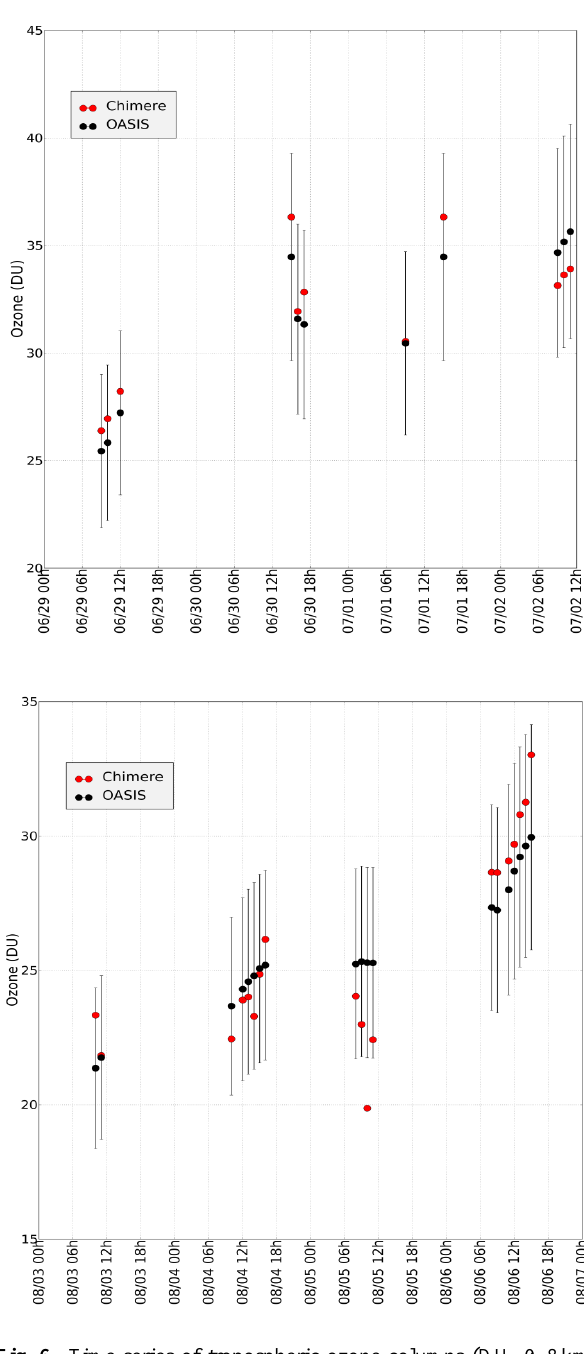
Fig. 6. Time series of tropospheric ozone columns (DU, 0–8km)